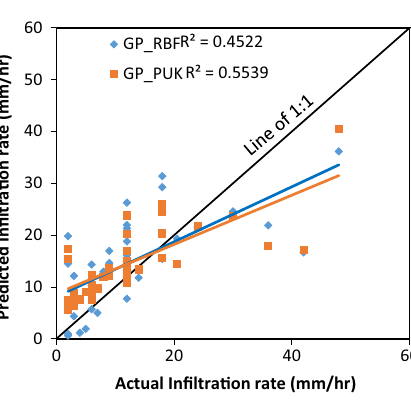
Fig. 4 Predicted infiltration rate of soil using SVR_RBF and SVR_